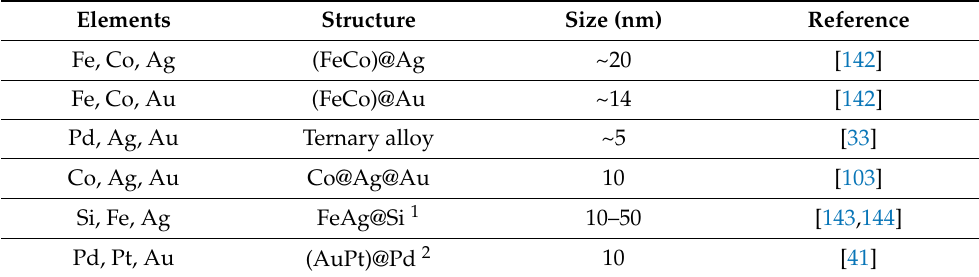
Table 2. List of three-element nanoparticles reported.